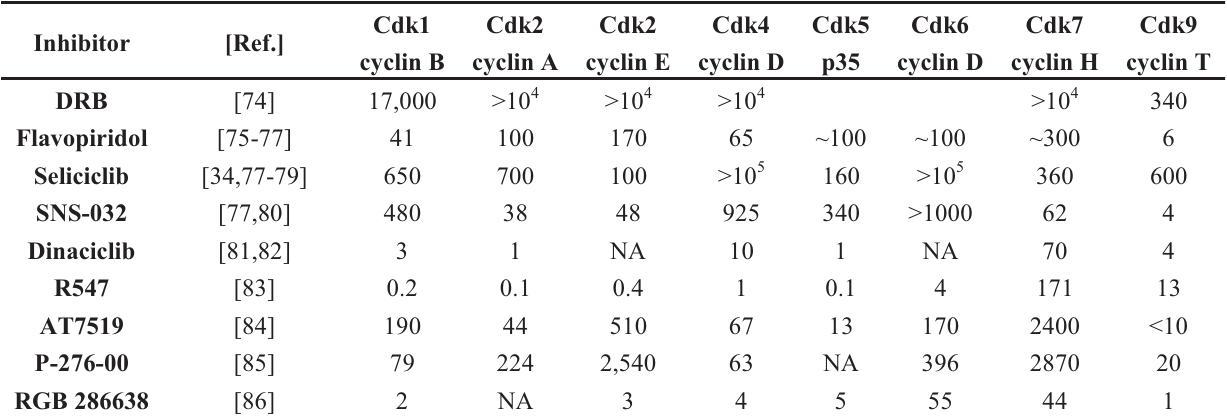
Table 2. The IC for CDK inhibition, as measured by in vitro kinase 50